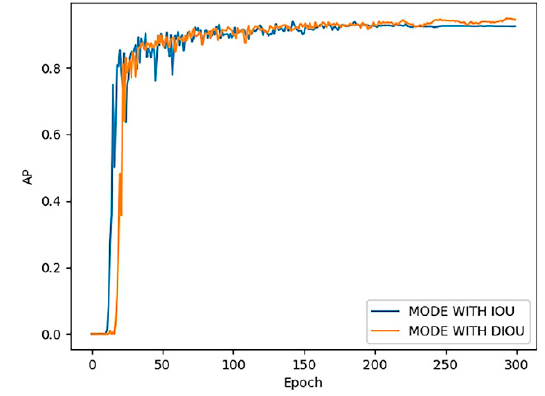
Figure 17. AP curve for IoU and DIoU.